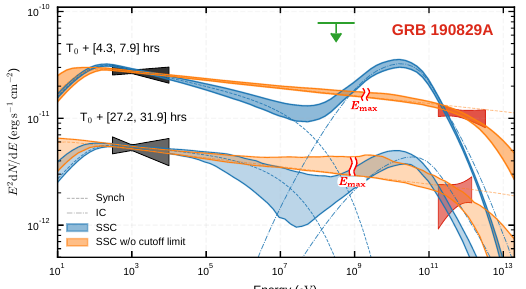
Figure 25. GRB190829A: modeling of X-ray, LAT and H.E.S.S. data proposed by the H.E.S.S. collab- oration for the two time intervals with VHE and X-ray detections. Two scenarios are investigated for the TeV emission: synchrotron and SSC. H.E.S.S. flux contours are displayed considering the statistical uncertainty. The synchrotron and SSC component are shown in dashed and dash-dotted lines, respectively. The shaded areas represent the 68% confidence intervals determined from the posterior probability distribution of the MCMC parameter fitting for the standard SSC model (light blue) and for the model without maximum energy for synchrotron emission (orange). From [5].